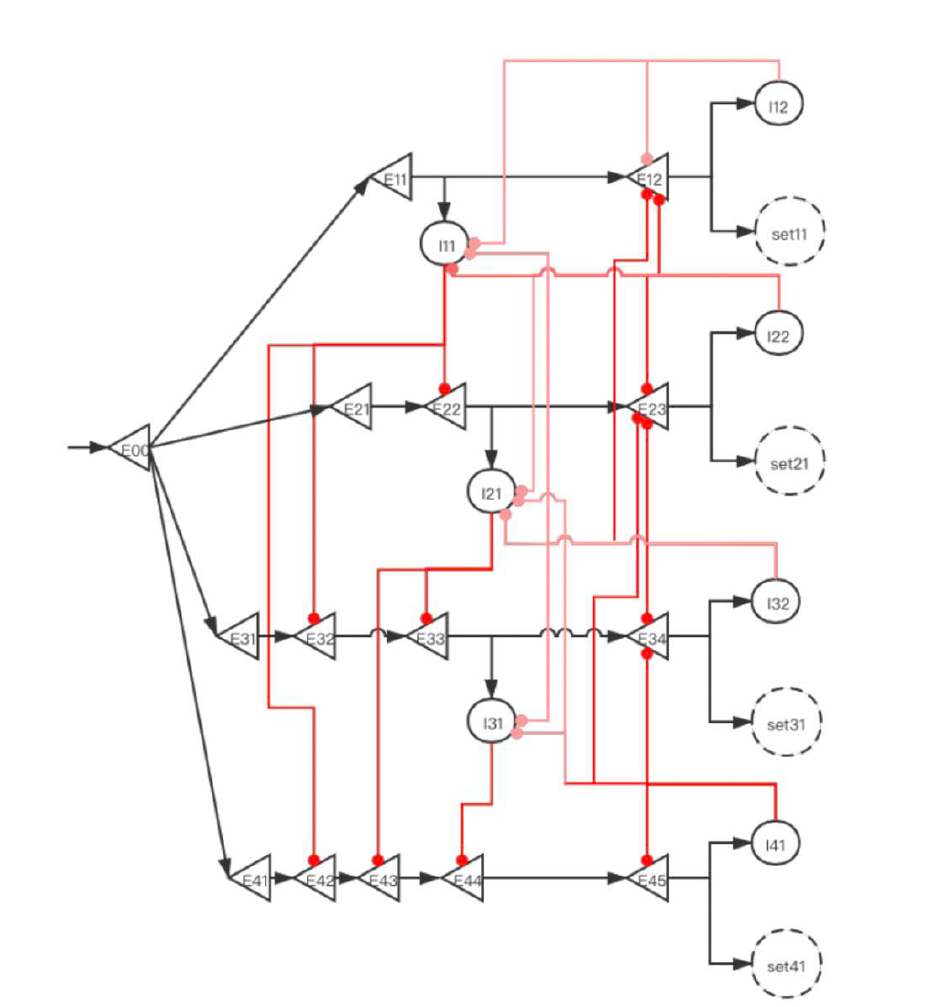
Figure 6. A storage distribution network implemented by pyramidal cells and interneurons. Light red indicates the inhibitory connection of interneurons to interneurons, and dark red indicates the inhibitory connection of interneurons to pyramidal cells. Pyramidal cells are a type of excitatory neurons, so “(E00, E11, E12...)” are used as the abbreviations for pyramidal cells. Interneurons are a type of inhibitory neurons, so “(I11, I12, ...)” are used as the abbreviations for interneurons.“set” in the paper is the same as “SET”. In the absence of interference, we use the FIFO principle to explain the forgetting of working memory. The network fulfills the forgetting of memory over time at the neural network level and reveals the process of the storage of memory and replacement of multiple memory items at the neural network